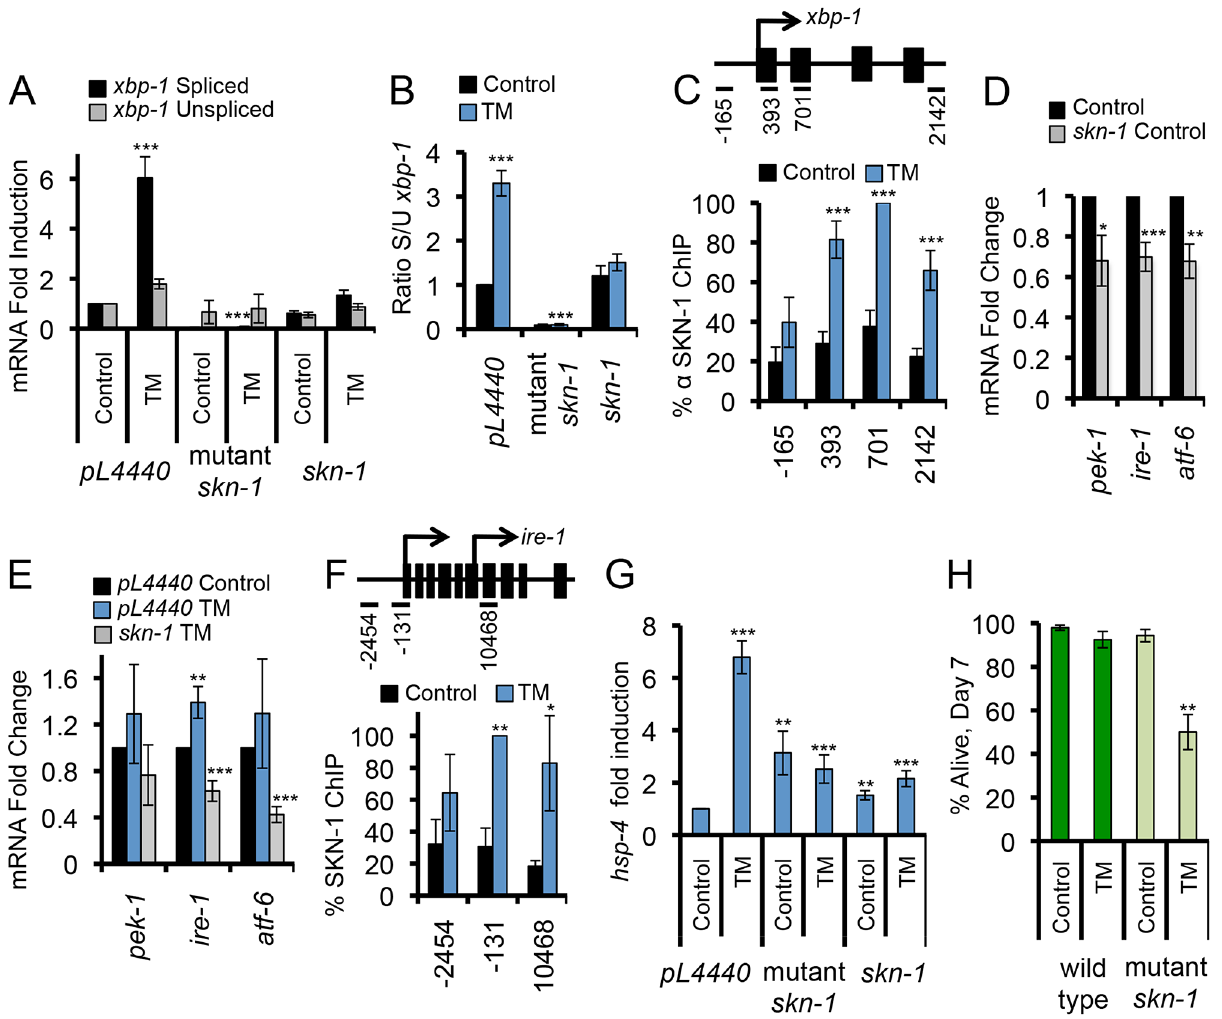
Figure 3. SKN-1 regulates core UPR genes. (A) SKN-1 is required for TM-induced accumulation of spliced xbp-1 mRNA. Levels of xbp-1 mRNA forms were analyzed by qRT-PCR with isoform-specific primers, and are presented as the xbp-1s/xbp-1u ratio in (B). skn-1 RNAi and mutant animals were analyzed compared to wild type. skn-1 refers to skn-1 RNAi, and skn-1 mutant refers to the skn-1(zu67 ) allele in all figures unless otherwise indicated. (C) ER stress induces SKN-1 recruitment along the xbp-1 gene. ChIP analysis is presented as in Figure 2. (D, E) Importance of skn-1 for expression of core UPR genes under basal (D) and TM-treatment (E) conditions, assayed by qRT-PCR. (F) Binding of SKN-1 to the ire-1 locus, analyzed by ChIP. (G) SKN-1-dependence of TM-induced hsp-4/BiP expression, assayed by qRT-PCR. (H) skn-1 mutants are sensitized to TM-induced ER stress. Survival of wild type and skn-1 mutant animals was assayed after 7 days of Control or high-dose TM treatment (35 m g/ml). Error bars represent SEM, and * p # .05, ** p # .01, *** p # .001, relative to pL4440 Control calculated using student’s t-test. See also Figure S3 and Table